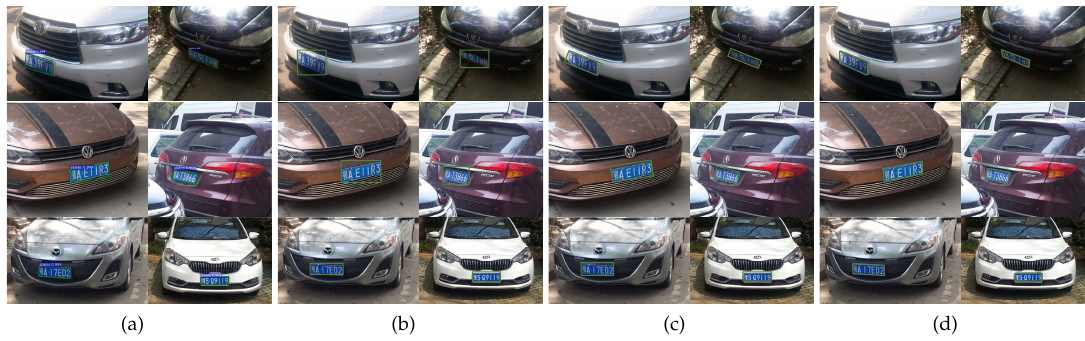
Figure 5. Some representative detection results: ( a ) MO-LPD ; ( b ) Faster R-CNN [27]; ( c ) RRPN [35]; ( d ) TextBoxes++ [37]. In each subfigure, license plates in the first to the last row were severely, modestly, and slightly skewed, respectively. The parallelograms predicted by MO-LPD contain less redundant information than the horizontal rectangles predicted by Faster R-CNN and rotated rectangles predicted by RRPN